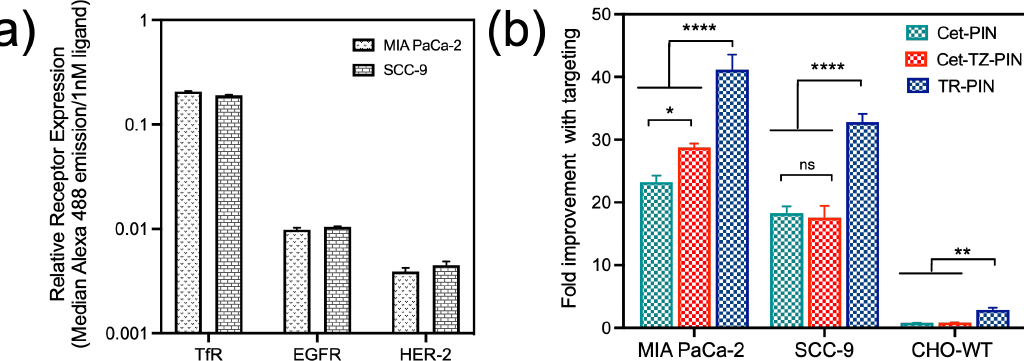
Figure 4. Triple-receptor-targeted PINs (TR-PINs) achieve higher binding specificity in MIA PaCa-2 and SCC-9 cells. ( a ) Relative receptor expression of EGFR, HER-2, and TfR in MIA PaCa-2 and SCC-9 cells determined using flow cytometry and represented as median fluorescence emission of Alexa Fluor 488 / 1nM ligand, when conjugated to cetuximab, transferrin, or trastuzumab, respectively. ( b ) Cellular binding data using Cet-targeted PINs (Cet-PINs), Cet- and TZ-targeted PINs (Cet-TZ-PINs), and triple-receptor-targeted PINs (TR-PINs) show a significant improvement in binding with TR-PINs, as compared with Cet-PINs or Cet-TZ-PINs in MIA Paca-2 and SCC-9 cells. No obvious change in cellular binding in CHO-WT cells was observed with TR-PINs due to the lack of receptor expression. (mean ± S.E.M.; n = 3–9; one-way ANOVA with a Tukey post-test; **** = p ≤ 0.0001; ** = p ≤ 0.01; * = p ≤ 0.05). Table 3. * Fold improvement in the cellular binding of nanoconstructs to the tumor cells. Tumor